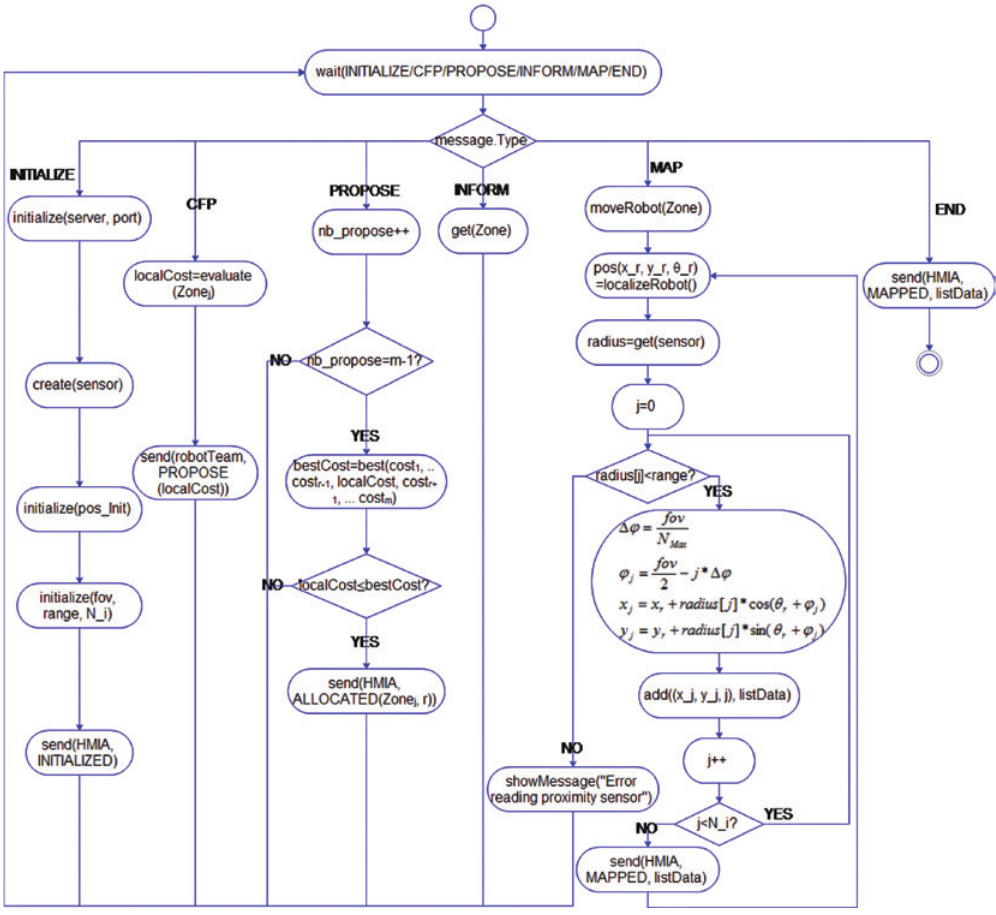
Figure 4: Behavior Diagram of Robot Agent